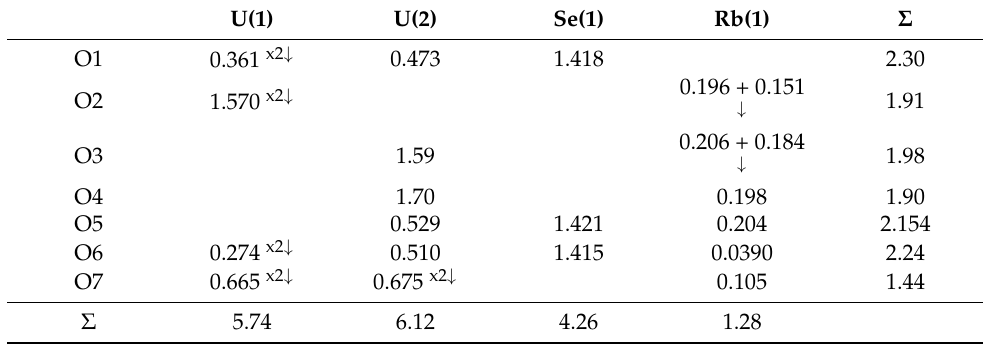
Table 3. BVS calculations for Rb 2 [(UO 2 ) 3 (SeO 3 ) 2 O 2